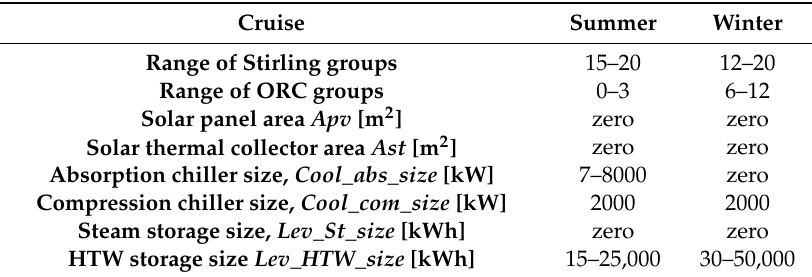
Table 5. Ranges for the optimization variables managed by the external